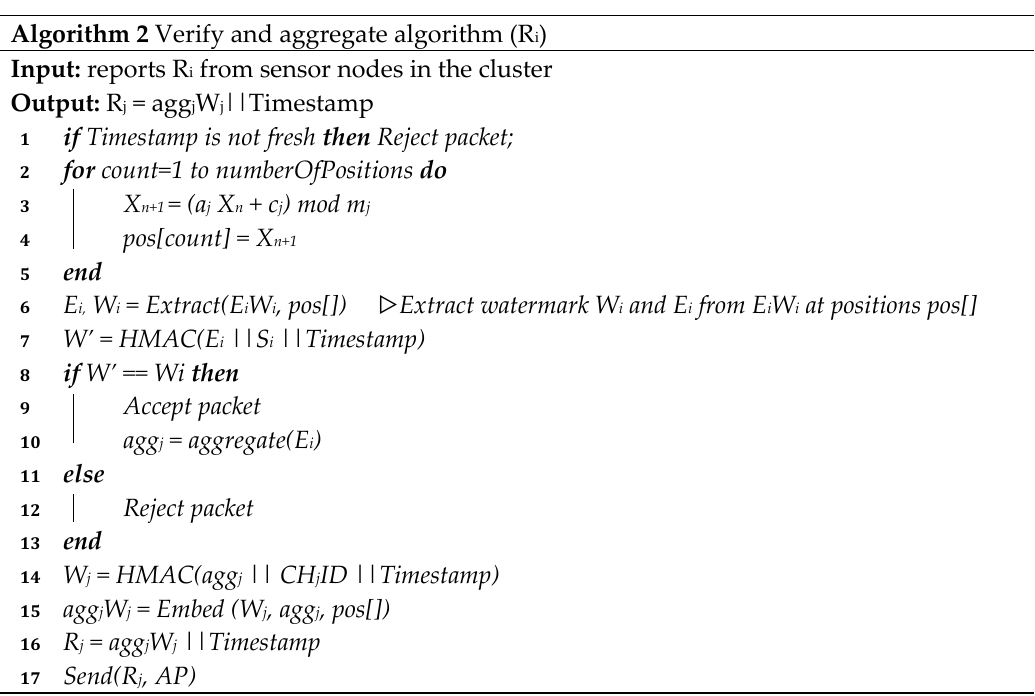
Algorithm 2. The pseudocode of the verifying and aggregation phase. Algorithm 2 Verify and aggregate algorithm (R i